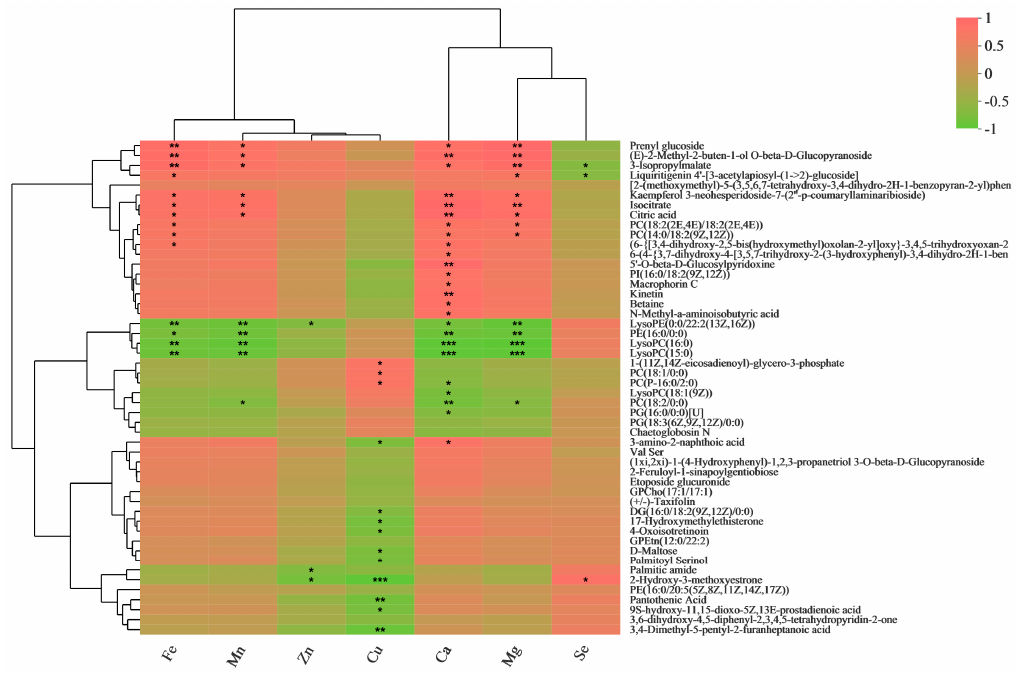
Figure 3. Correlation analysis of Fe, Mn, Zn, Cu, Ca, Mg, and Se with DMs. * p < 0.05; ** p < 0.01; *** p < 0.001.